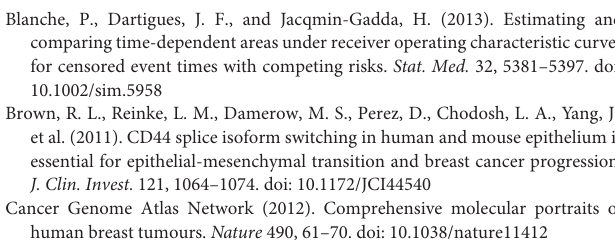
FIGURE S1 | Illustration for the splicing pattern of 20 particular AS events included in final 20-AS events-based classifier. The blue box indicates the exon while gray box indicates the intron. The specific AS events are marked with red lines. The parent genes and splicing types are presented on the left side. FIGURE S2 | The curve of the difference of time-dependent AUCs between final and other AS signature over time (3–8 years): (cid:77) AUC(t) versus t. The dashed bands indicated the pointwise 95% confidence intervals of estimated AUCs difference. The dashed line evaluates whether the difference of two estimated AUCs at each timepoint is statistical significance. (A–F) The curve of the difference of time-dependent AUCs between final and other AS signatures, including AA (A) , ES (B) , ME (C) , AP (D) , AD (E) , and AT (F) , respectively. FIGURE S3 | Application of the final AS signature in stratified BRCA cohorts. (A–H) Stratified Cox analysis of overall survival between high- and low-risk patients classified by different clinicopathological characteristics, including age (A) , histological subtype (B) , pathologic stage (C) , Her-2 status (D) , ER status (E) , PR status (F) , T stage (G) , and N stage (H) . FIGURE S4 | GSEA delineates biological processes and pathways correlated with the final 20 AS event-based classifier using gene sets of “c2.cp.v6.1.symbols” download from MSigDB. The BRCA cohort was divided into low- and high-risk subgroups. The running was conducted with 1000 permutations. GSEA validated enhanced activity of (A) “signaling by Wnt,” (B) “p53 dependent G1 DNA damage response,” (C) “SCF β -TRCP mediated degradation of EMI1,” (D) “SCFSKP2 mediated degradation of P27/P21,” (E) “regulation of ornithine decarboxylase odc,” (F) “mismatch repair,” (G) “activation of NF-KappaB in B cells,” (H) “FOXMI pathway,” (I) “BARD1 pathway,” and (J) “ARF6 downstream pathway.” FIGURE S5 | Kaplan-Meier plots of previous reported AS events in BRCA. (A) ES of CD44 (CD44v) were significantly survival associated with OS at median cut. (B) ES events of FLNB was significantly associated with OS with modified cutoff value. TABLE S1 | Collection of 67 human splicing factors from the SpliceAid 2 database. TABLE S2 | Detailed enrichment results of GO terms and KEGG